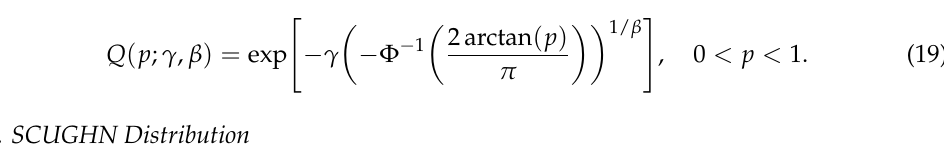
The CDF and PDF of the SCUGHN distribution are developed by substituting Equa- tion (9) into (7) and, Equations (10) and (9) into (8). Therefore, the corresponding CDF is given by